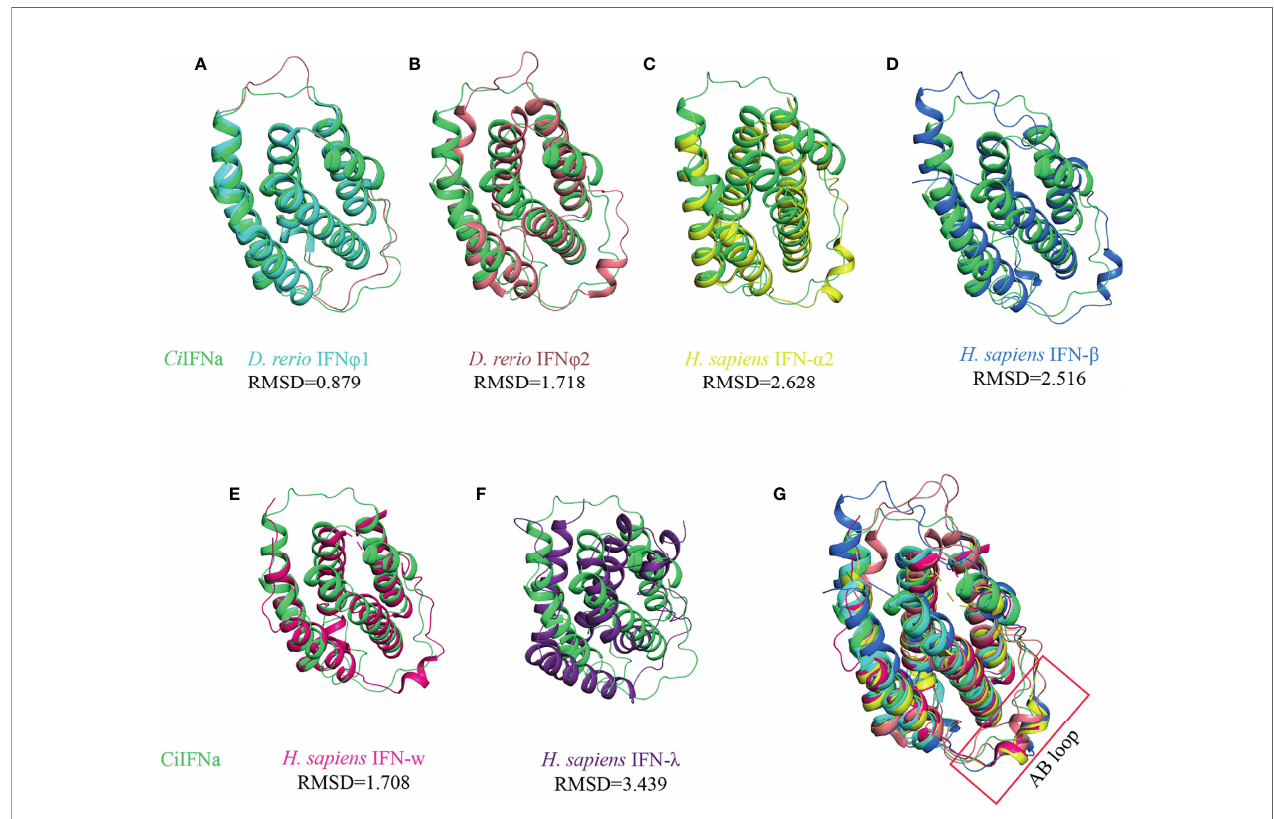
FIGURE 4 | Structural comparison of Ci IFNa with type I and III IFNs. All the structures are shown in cartoon. The CiIFNa was superposed with zebra fi sh IFN j 1 (A) , zebra fi sh IFN j 2 (B) , human IFN- a 2 (C) , human IFN- b (D) , human IFN-w (E) and human IFN- l (F) . The differences of AB loop are indicated (G) . The structure data of zebra fi sh IFN j 1 (PDB: 3piv) and IFN j 2 (PDB: 3piw), and human IFN- a 2 (PDB: 3se3), IFN- b (PDB: 1au1), IFN-w (PDB: 3se4) and IFN- l (PDB: 3hhc) were retrieved from the PDB database. The structures of IFNs are shown in different